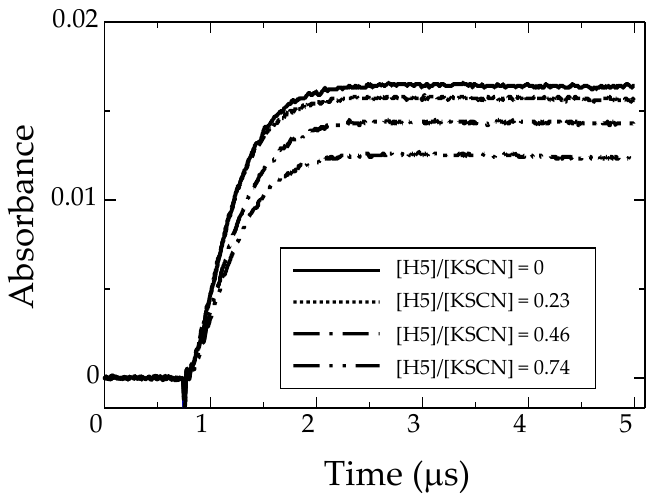
Figure 4. Time profiles of absorption at 500 nm for the mixed aqueous solutions of H5 with KSCN in the ratio of 0 (solid line), 0.23 (dotted line), 0.46 (single-dashed line), and 0.74 (double-dashed line). The absorbance of (SCN) 2 − · at 500 nm decreased with increasing H5 in the aqueous KSCN solution (Figure 4). These results indicate that reactions between SCN − or H5 with OH radicals (Equations (4) and (6)) occur